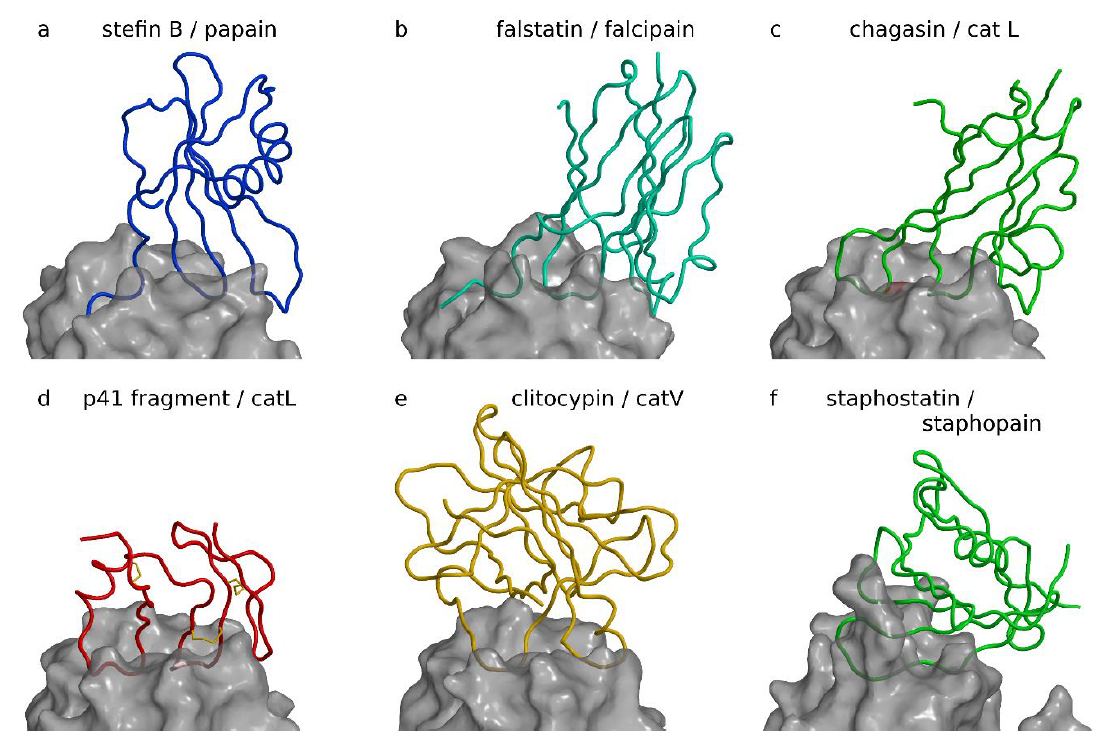
Figure 1. Inhibitors of papain-like and related proteases. Complexes are shown with the same view across the active site cleft and the same scale after superimposition of proteases to cathepsin L in the p41 fragment complex. Figure was prepared using MAIN [35] and rendered with Raster3d [36]. ( a ) Stefin B papain complex ([21], PDB code 1STF). The stefin B chain is shown as a blue coil on the semitransparent background of the white surface of papain. ( b ) Inhibitor of cysteine protease (ICP) (falstatin) falcipain complex ([37], PDB code 3PNR). ICP, also known as falstatin from Plasmodium berghei, is shown as a cyan coil on the semitransparent background of the white surface of falcipain-2. ( c ) Chagasin cathepsin L complex ([38], PDB code 2NQD). The chagasin chain is shown as a green coil on the semitransparent background of the white surface of cathepsin L. ( d ) p41 fragment cathepsin L complex ([39], PDB code 1ICF). p41 fragment chain shown as a red coil on the semitransparent background of the white surface of cathepsin L. The three disulfide bonds of the p41 fragment are shown as yellow sticks. ( e ) Clitocypin cathepsin V complex ([40], PDB code 3H6S). The clitocypin chain is shown as a yellow coil on the semitransparent background of the white surface of cathepsin V. ( f ) Staphostatin staphopain complex ([41], PDB code 1PXV). The staphostatin chain is shown as a green coil on the semitransparent background of the white surface of staphopain. Table 1. List of the available structures of the complexes between protein inhibitors and cysteine proteases: cystatins. Protein Inhibitor